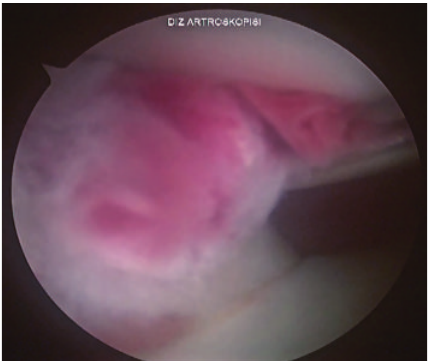
Figure 3: Mobilization of the intrasubstance ruptured popliteus tendon into the joint, causing impingement.